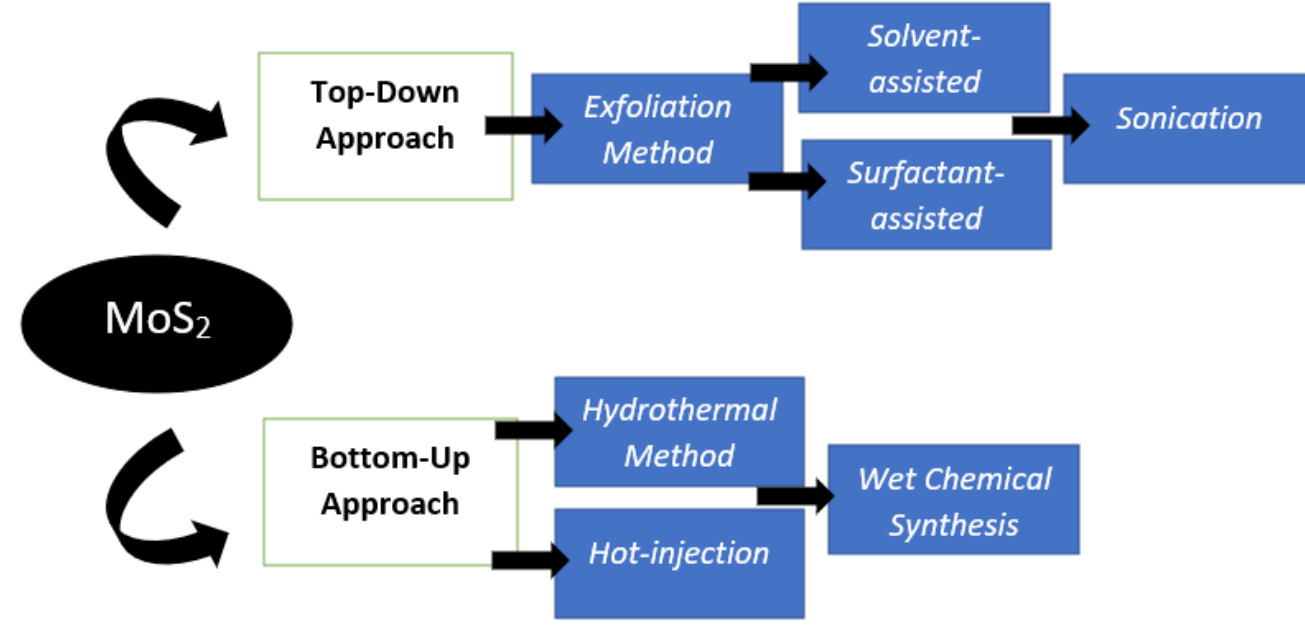
Figure 7. Overview diagram of the MoS 2 preparation procedures.